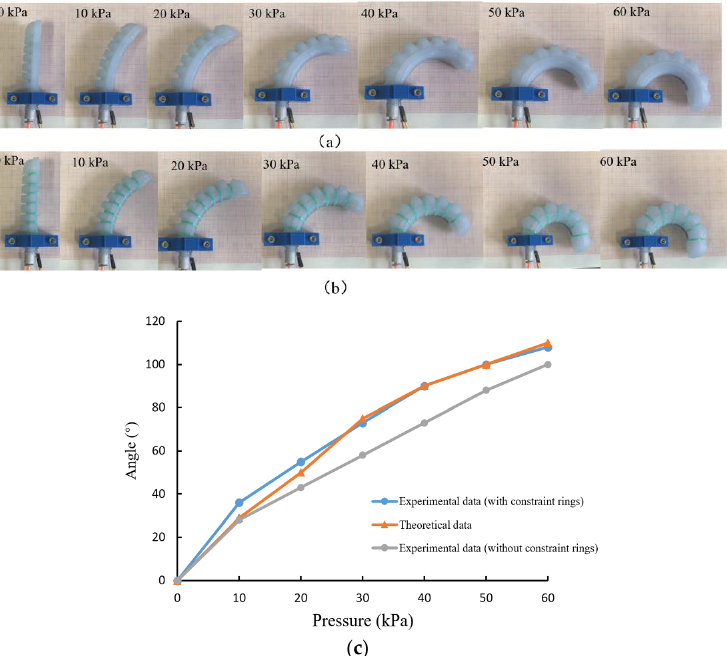
Figure 15. Results of bending experiments of soft actuators. ( a ) The bending angle of the soft actuator under different air pressure without constraint ring. ( b ) The bending angle of the soft actuator under different air pressure with constraint ring. ( c ) Comparison of experimental structure and theoretical results of soft actuator bending angle.